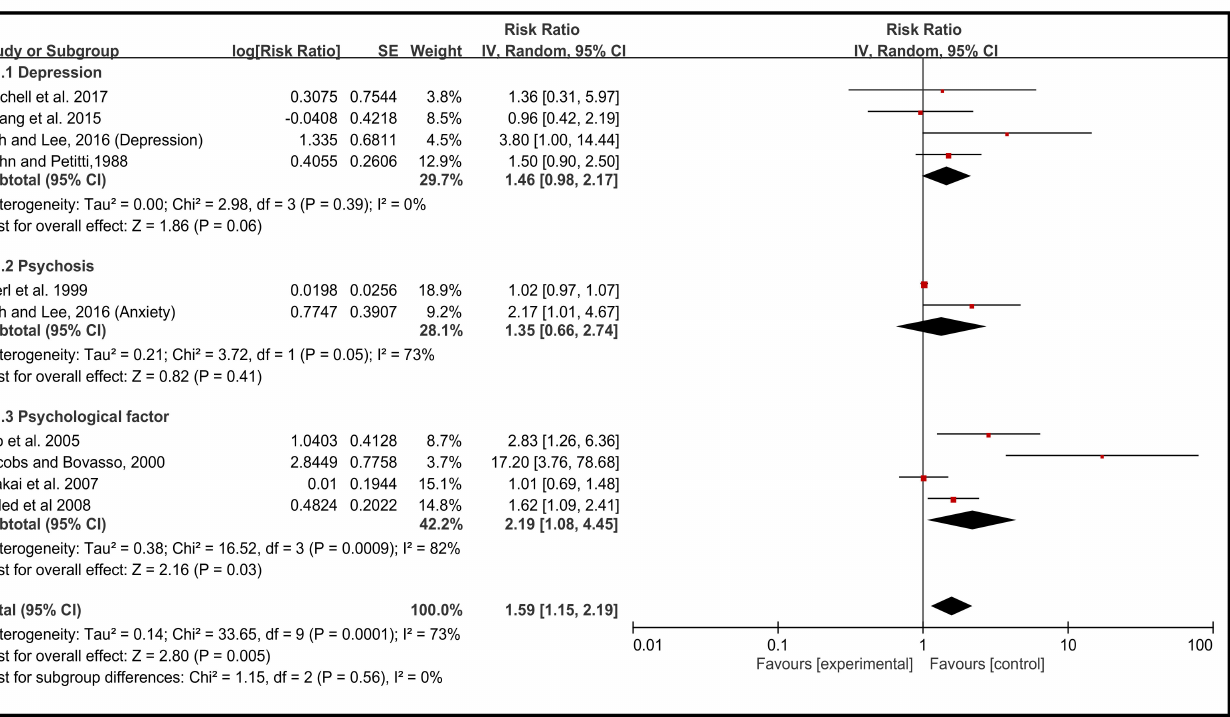
Figure 2. Effect of the NEs on the incidence of BC [43–51].